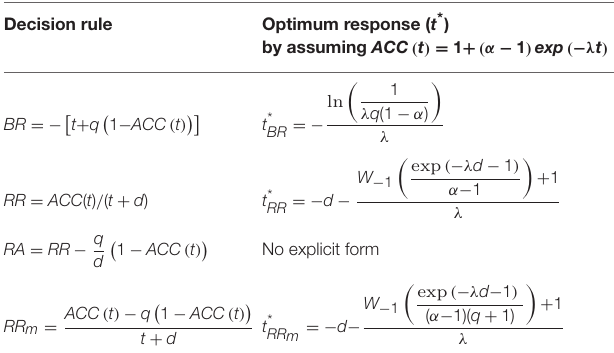
TABLE 1 | Summary of decision rules with associated optimum response time t * for the exponential ACC ( t ) in Equation (1). Decision